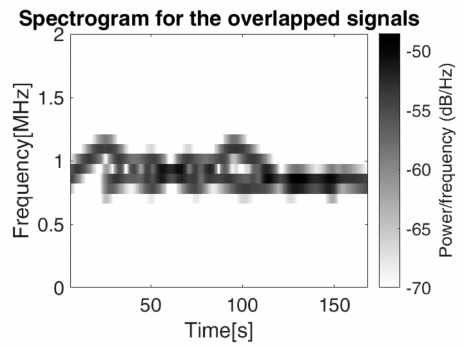
Figure 16. The spectrogram of the signal s IFL 12 containing two overlapped IF laws computed for a window of 128 samples, 120 overlapping samples and 128 points for the Fourier transform